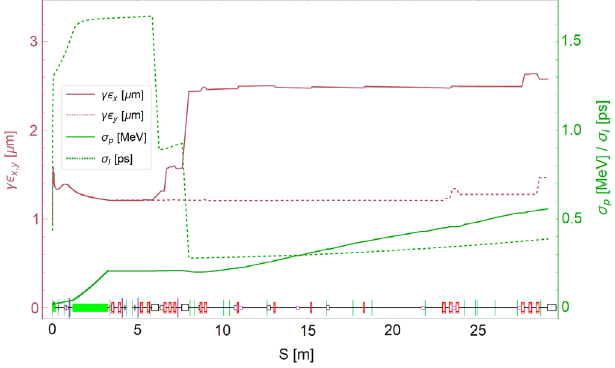
FIG. 6. Transverse normalized emittances and longitudinal momentum spread in the CLARA to BA1 beam line. These parameters have been calculated using ELEGANT with an off-crest linac phase of − 10 ° (maximum compression) and including longitudinal space-charge and CSR effects. The horizontal emittance has been truncated at 5 μ m rad.